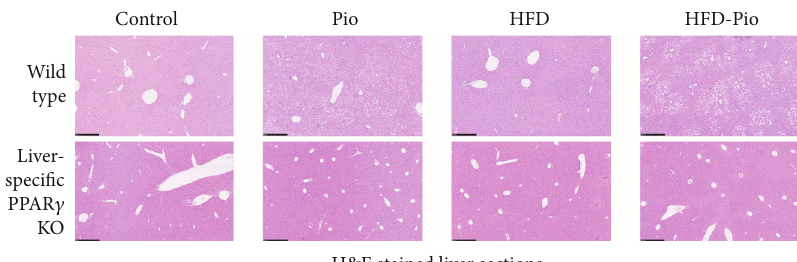
Figure 2: E ff ects of Pio on WT and KO mouse liver histology. H&E -stained liver sections from control diet (Control)-, Pio-, high-fat diet (HFD)-, or HFD and PIO (HFD-Pio)-treated mice. 500 micron bar shown in lower left